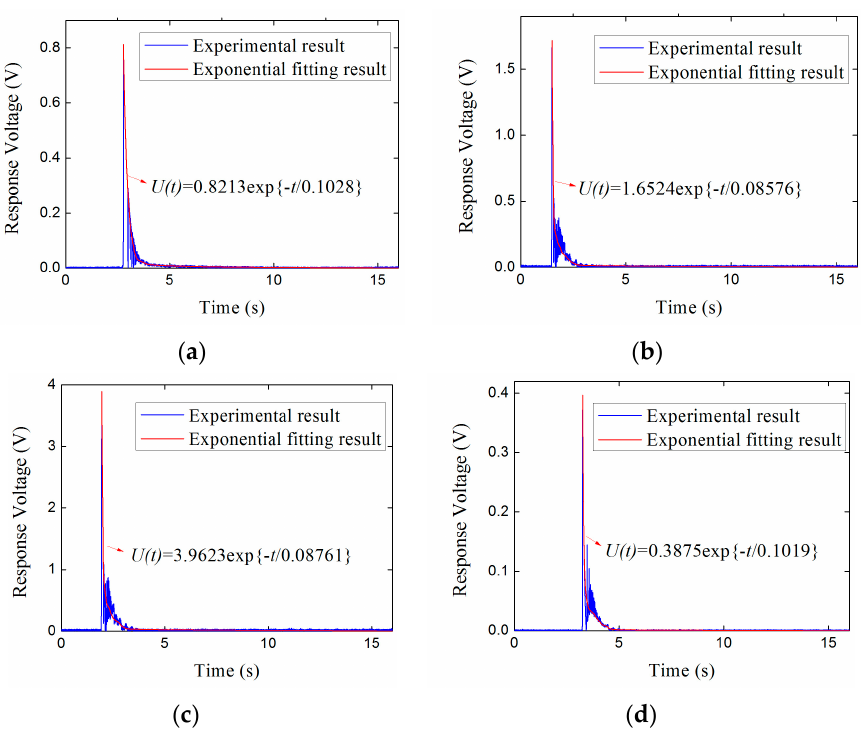
Figure 18. Exponential fitting results of the response voltages. ( a ) Subset 1-2; ( b ) Subset 2-2; ( c ) Subset 3-3; ( d ) Subset 4-1.